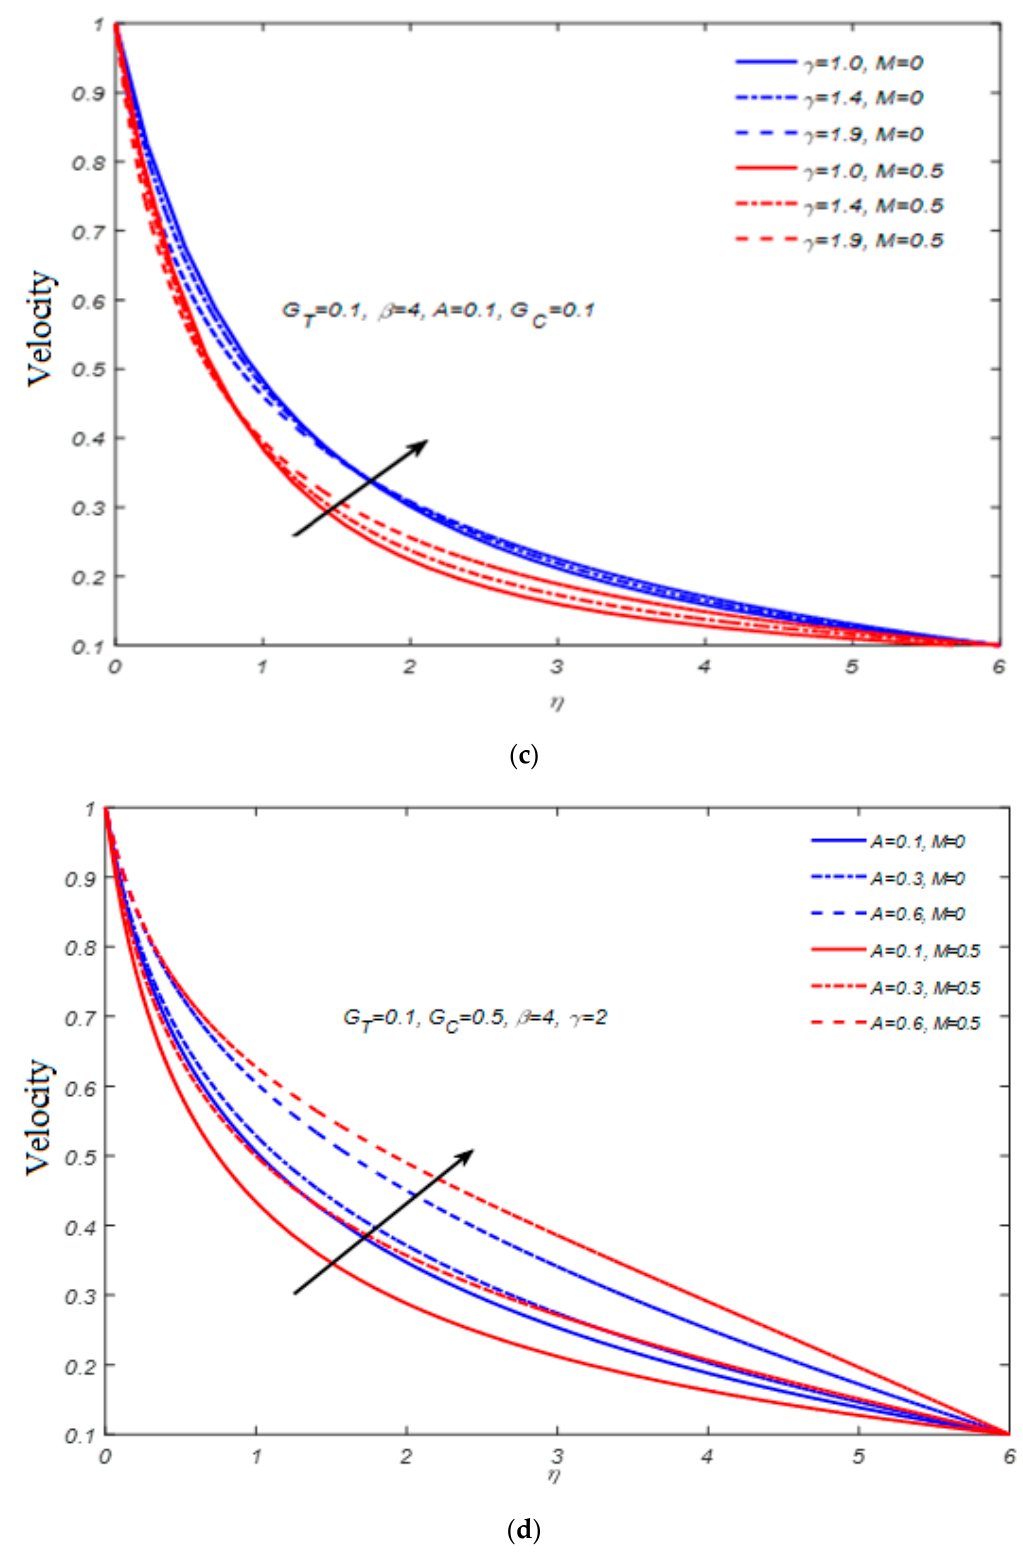
γ β η η on '( ) f . ( c ) Impact of on '( ) f . ( d )